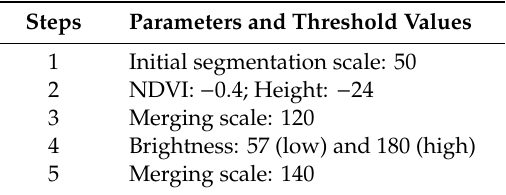
Table 1. The threshold values used in each step for generation of tree-crown object. Steps Parameters and Threshold Values 1 Initial segmentation scale: 50